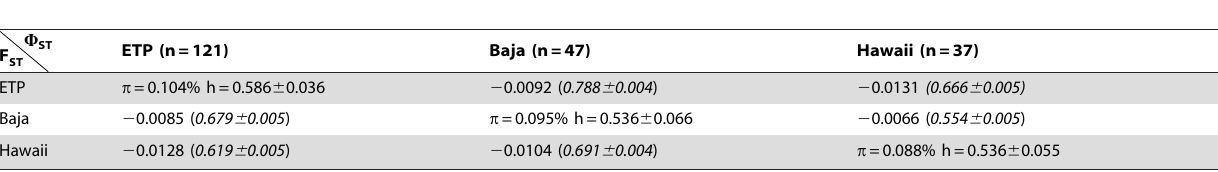
Table 4. Pairwise Fst (below diagonal) and W st (above diagonal) values for the COI gene when only Clade B haplotypes of Alopias pelagicus are